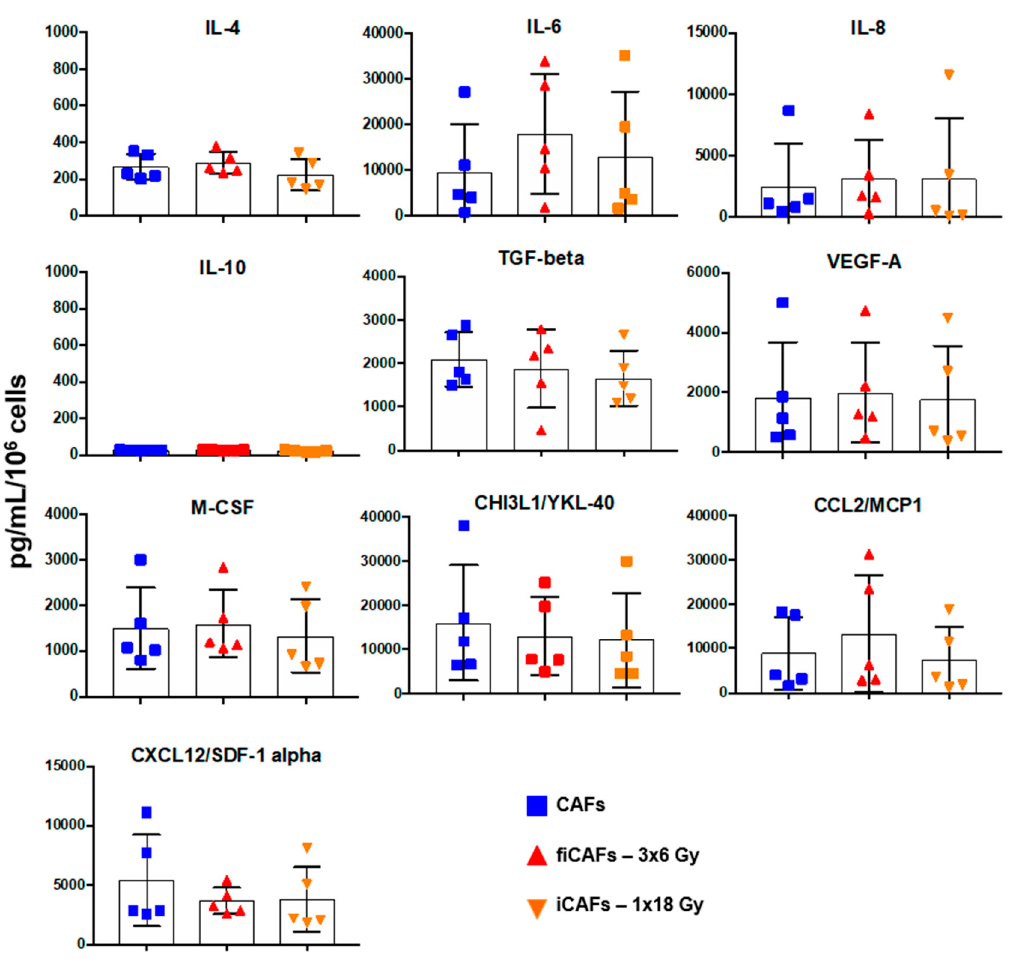
Figure 7. Effects of radiation on CAF-mediated secretion of inflammatory mediators. The release of various macrophage regulatory factors from CAFs was measured in the various CAF-CMs (5 days post-IR) by panels of multiplex protein arrays and ELISA. Results are expressed as fold CAF-control. Mean values from five different CAF donor samples are shown.